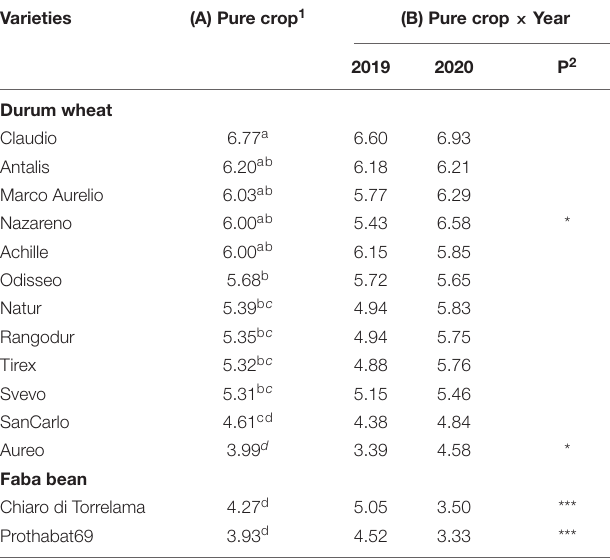
TABLE 1 | Pure crop yields (Mg ha − 1